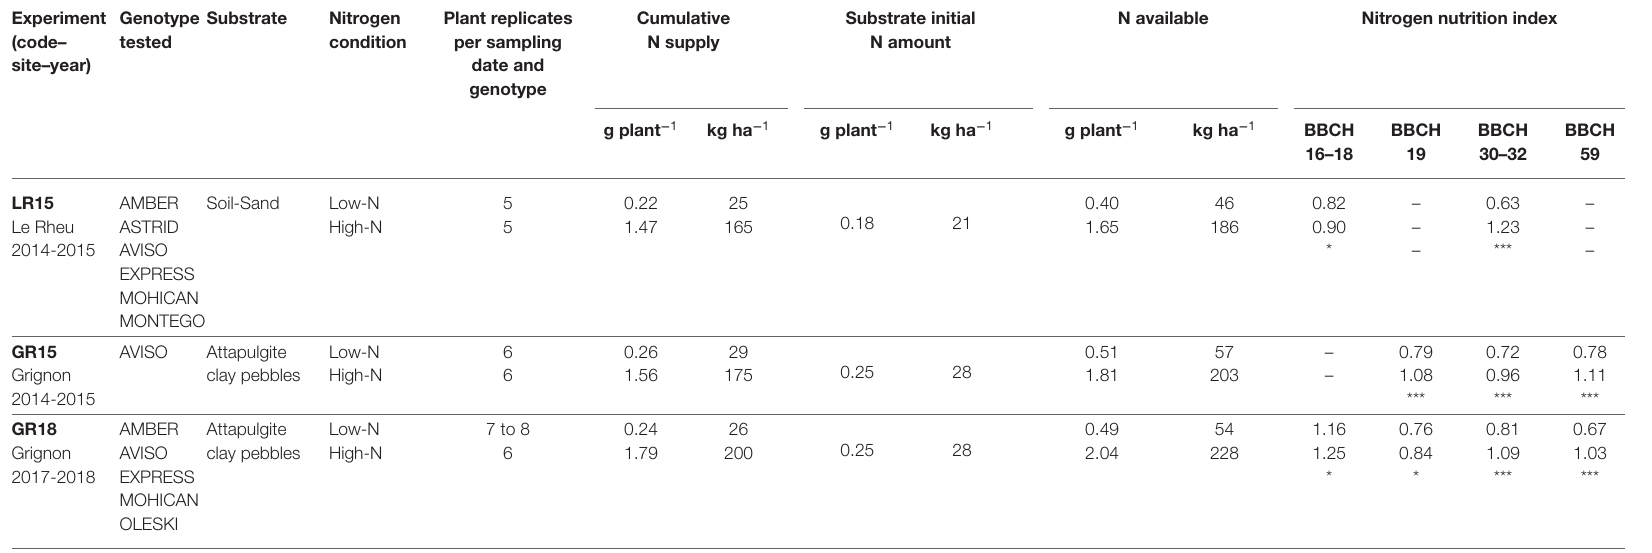
TABLE 1 | Overview of the experimental design: genotypes tested, substrates, nitrogen (N) conditions, and number of plant replicates per sampling date × genotype under each N condition in the three experiments. Experiment